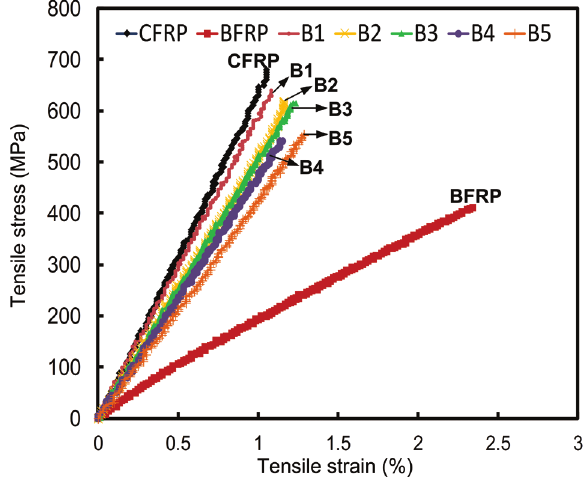
Figure 3 Stress-strain curves of CFRP, BFRP, and hybrid composites with different numbers of basalt fiber